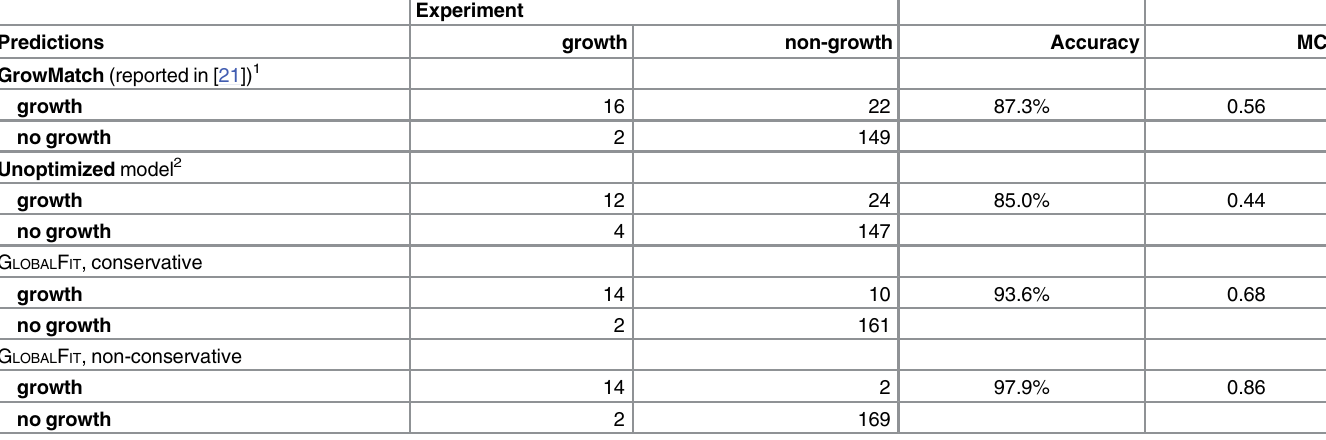
Table 1. Comparison of experimental and predicted viability for 187 M. genitalium gene